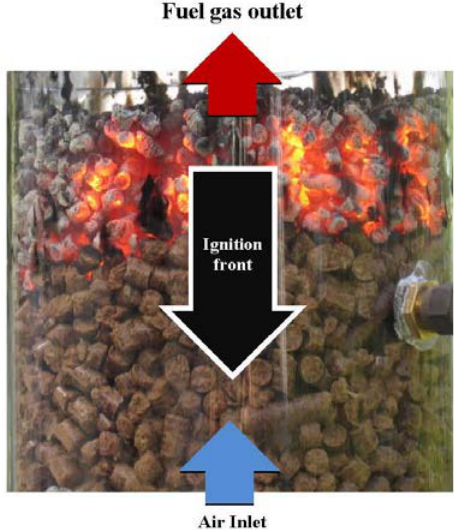
Figure 3. Model diagram for ignition front propagation in a fixed